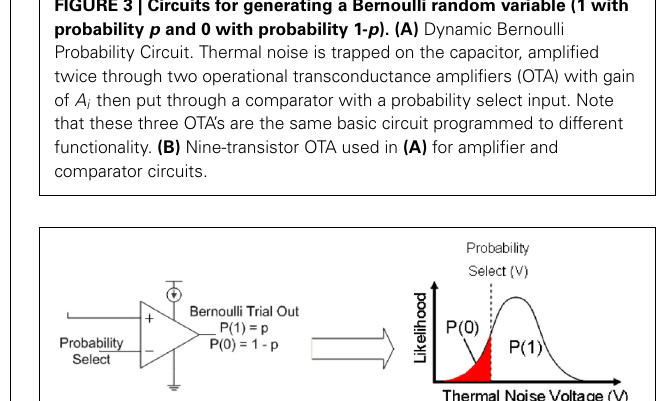
FIGURE 2 | Circuit used to take advantage of the well-defined thermal noise properties on a capacitor where the root-mean-square (RMS) (cid:2) kT FIGURE 4 | The probability distribution function of thermal noise and . The thermal noise on voltage of the noise on a capacitor is V n = C the probability of generating a P (1) or P (0) in the Bernoulli variable this capacitor is used as the gate voltage for PMOS and NMOS transistors generating circuit. The probability of a 1 is the integral under the where a current with the same spectrum as the thermal noise is generated. probability distribution function of the thermal noise from the comparator This ultimately produces a voltage controlled current through the voltage to the supply voltage of the circuit, V dd diode-connected transistor.